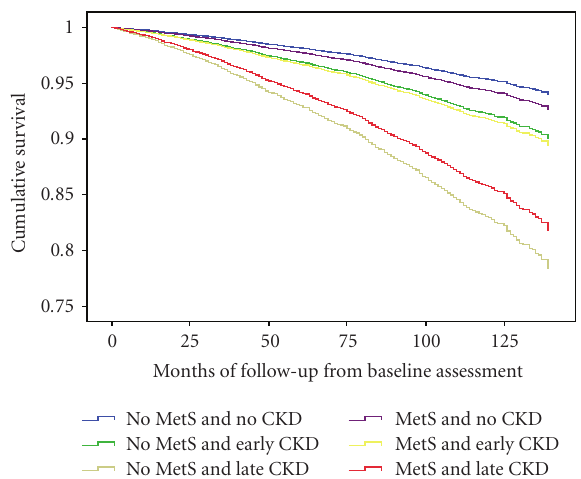
Figure 1: Survival function for CVD mortality versus cocustered metabolic syndrome and renal dysfunction. MetS stands for metabolic syndrome and CKD stands for chronic kidney disease.